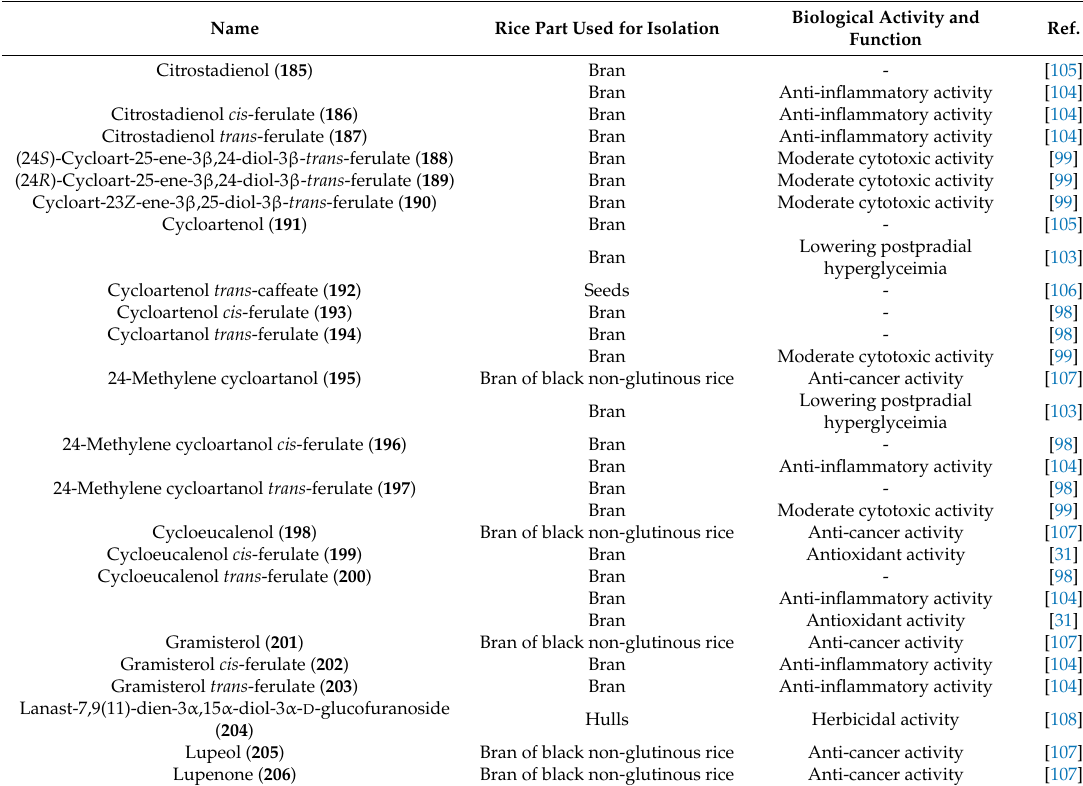
Figure 6. Structures of the triterpenoids isolated from rice. Table 6. Triterpenoids and their biological